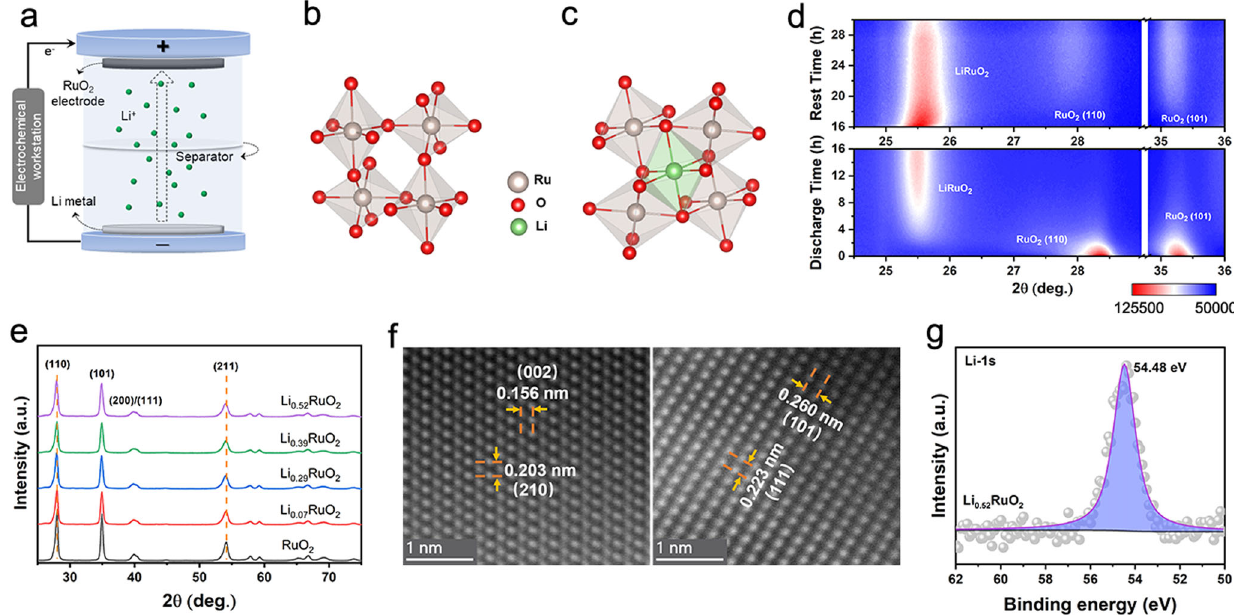
Fig. 1 Structural and compositional characterizations. a Schematic illustration of the preparation of lithium intercalated RuO 2 . b RuO 6 octahedron before lithium intercalation. c RuO 6 octahedron after lithium intercalation. d Operando XRD of RuO 2 during electrochemical lithiation under a constant current density of 10 mA g − 1 , followed by 14 h relaxation. e Ex situ XRD patterns of the pristine RuO 2 and the Li x RuO 2 . f The HAADF-STEM images of the pristine RuO 2 (left) and the Li 0.52 RuO 2 (right). g The high-resolution Li 1 s XPS of Li 0.52 RuO 2